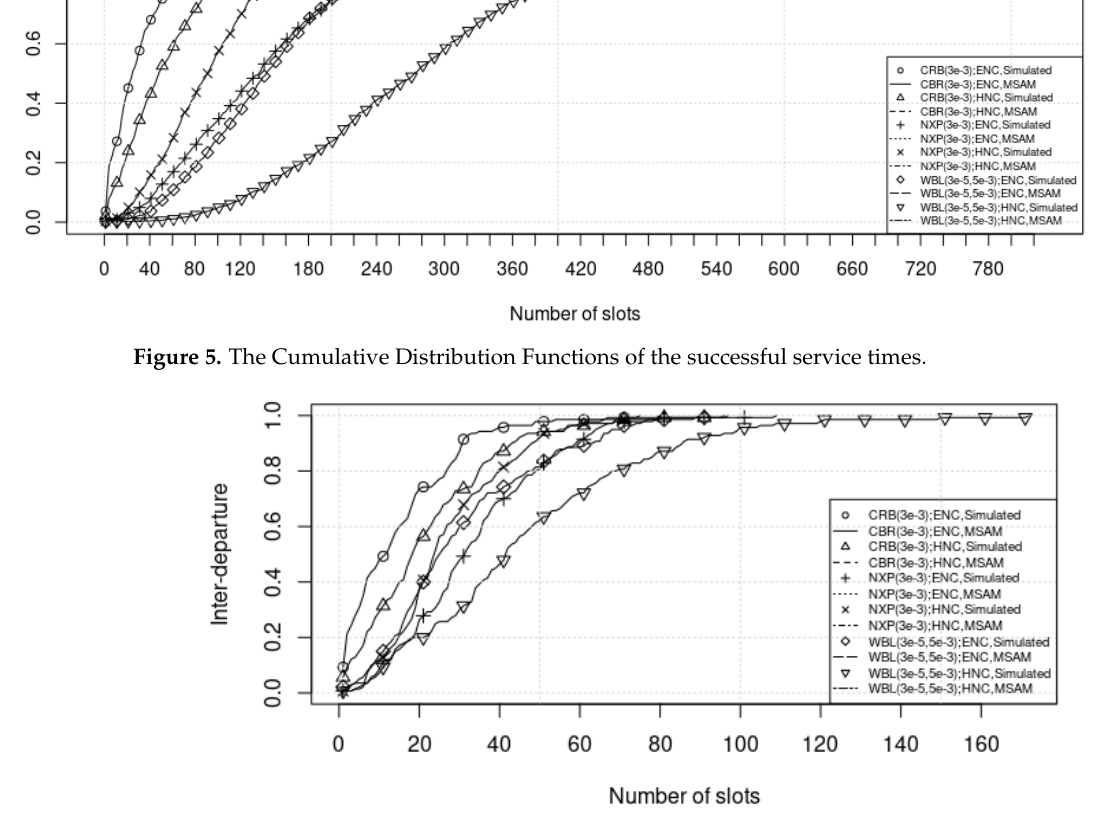
Figure 7. The Cumulative Distribution Functions of the queuing delay.